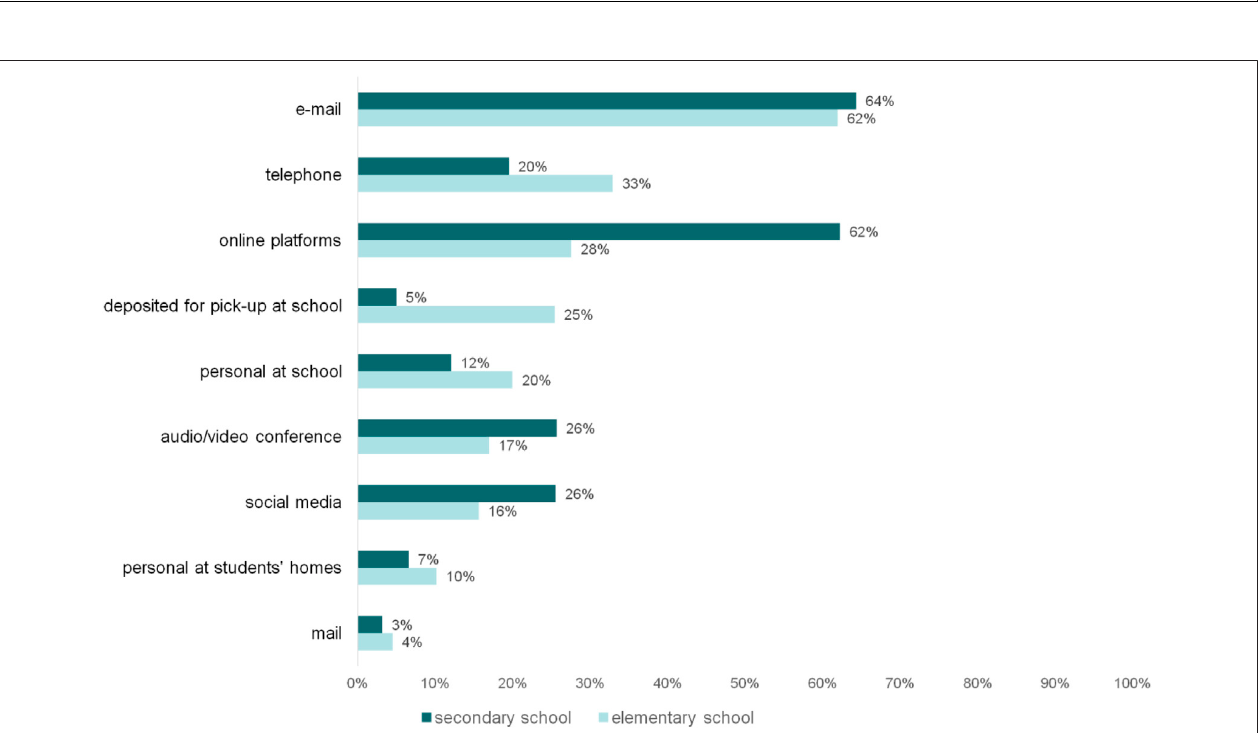
FIGURE 5 | Percentage of teachers giving feedback to their students via different communication channels at least once a week.